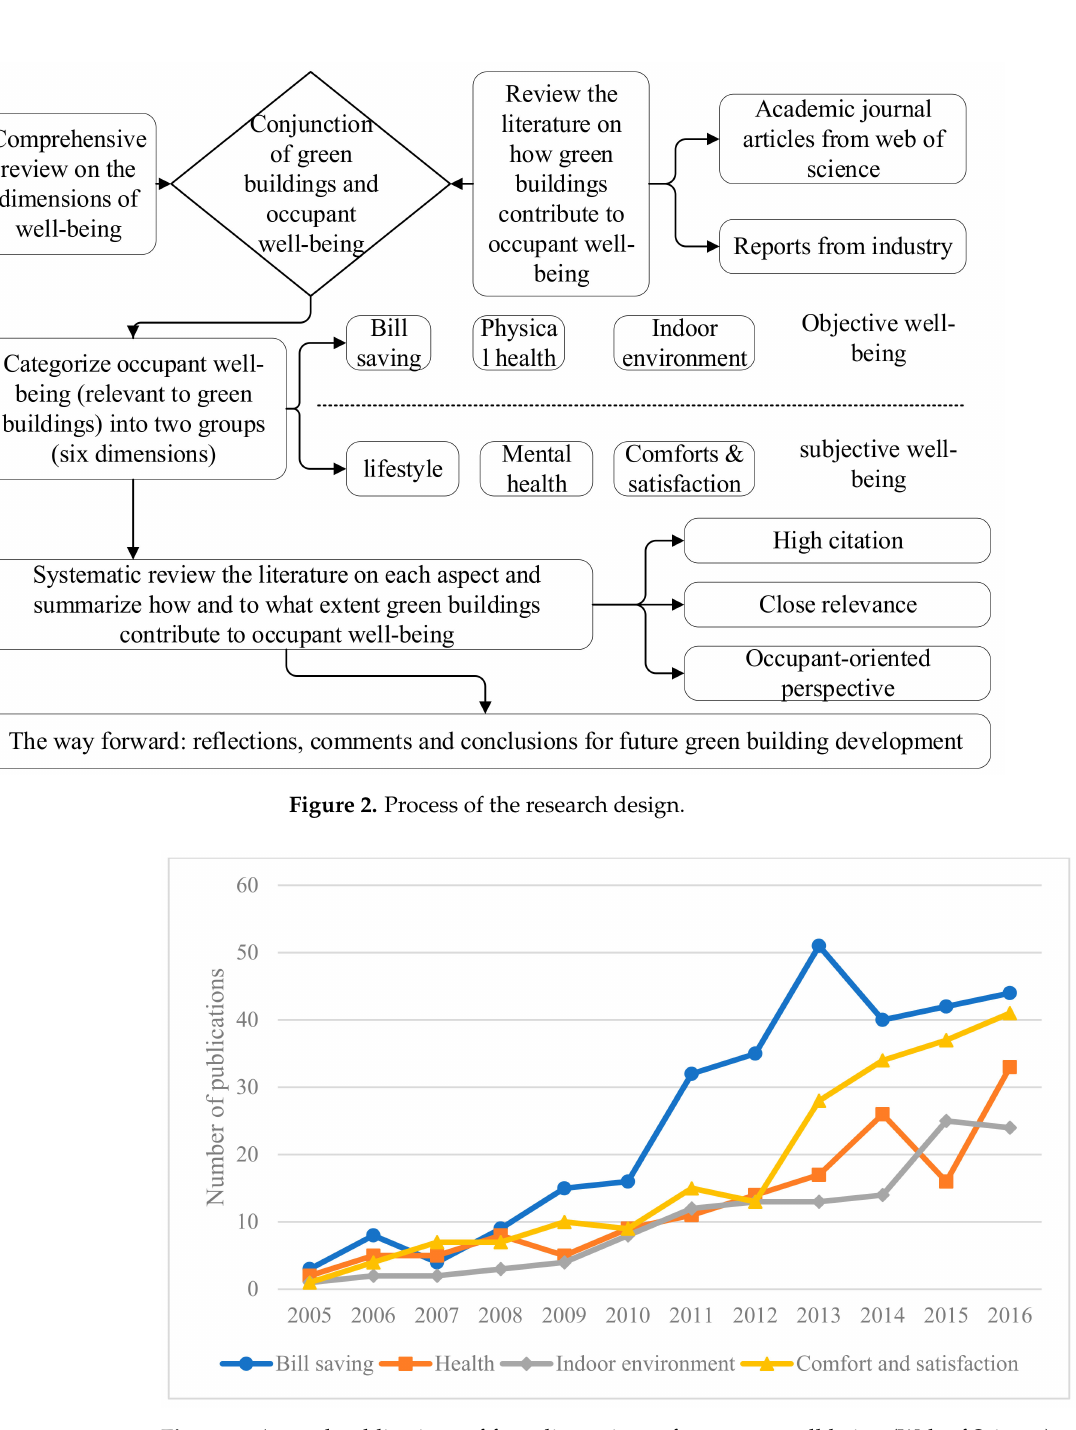
Figure 3. Annual publications of four dimensions of occupant well-being (Web of